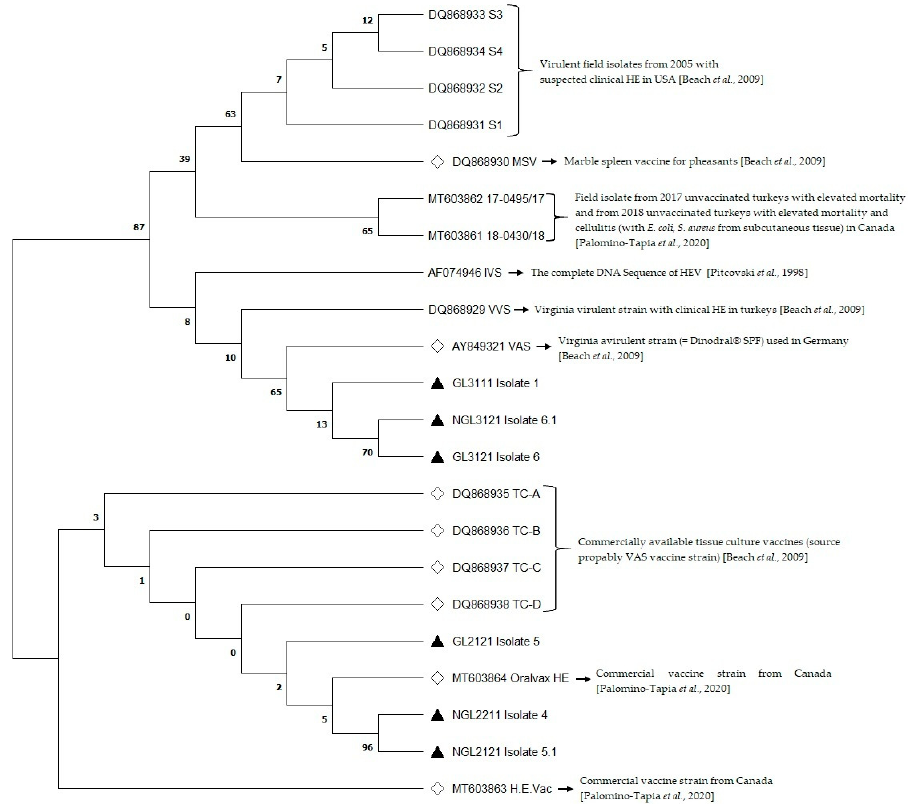
Figure 1. Phylogenetic tree based on concentrated sequences of partial ORF1, E3, and Fiber knob genes (original tree). The evolutionary history was illustrated using the maximum likelihood method and the JTT matrix-based model [41]. The tree with the highest log-likelihood ( − 1554.26) is indicated. The percentage of trees in which the associated taxa are clustered is indicated next to the branches. For this analysis, the Neighbor-Join and BioNJ algorithms were applied to a matrix of pairwise distances estimated using the JTT model and the topology with the superior log likelihood value. This analysis included 22 amino acid sequences. Six sequences belonging to this study are marked with a black triangle. Vaccine strains are marked with an empty square. The phylogenetic analysis was based on the amino acids of six sequences from this study in comparison to 16 reference sequences from NCBI [17,39,51]. The final data set included a total of 496 positions. The evolutionary analyses were performed in MEGA X